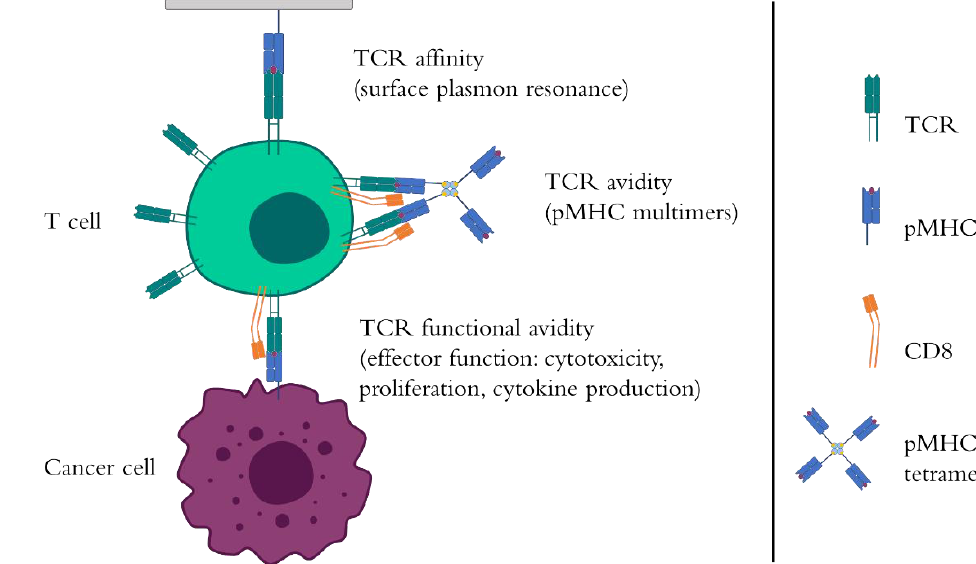
Figure 1. The interaction between the T-cell receptor (TCR) and the peptide-major histocompatibility complex (pMHC). T cells recognize tumor peptide epitopes via the pMHC. Different parameters affect the sensitivity that T cells, including T-cell receptor (TCR)-engineered T cells, will display against the pMHC. TCR affinity describes the strength of the interaction between a single TCR and pMHC. It is commonly measured using a technique named surface plasmon resonance. TCR avidity, on the other hand, reflects the contact of multiple TCRs and pMHCs. For this reason, multimers consisting of a number of pMHCs linked via streptavidin–biotin complexes to a fluorochrome are used to stain antigen-specific T cells and measure their TCR avidity. This parameter also takes into account the effect of T-cell co-receptors such as CD8 in the stabilization of TCR–pMHC binding. Closely related to TCR avidity, functional avidity shows the T-cell fitness to a target antigen in terms of its activation and effector functions, namely, T-cell proliferation, antitumor cytotoxicity, cytokine production, upregulation of activation markers, among others.